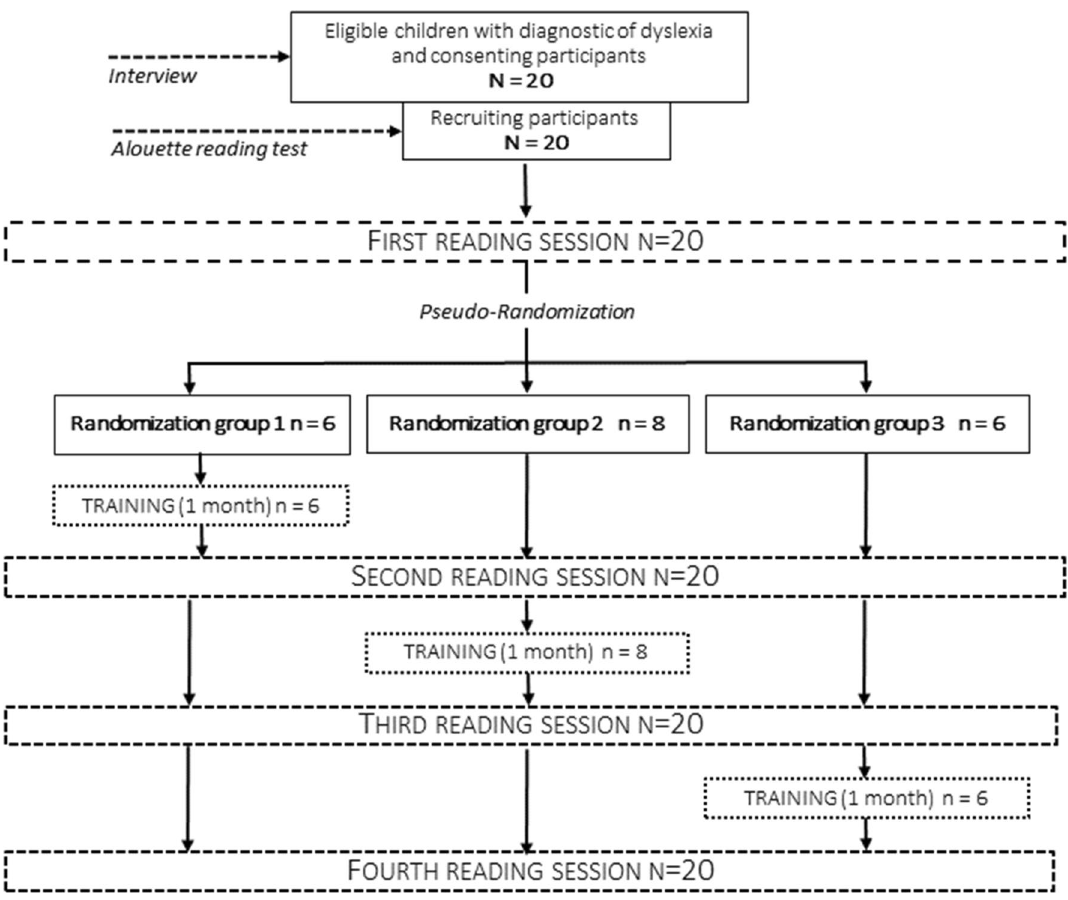
Figure 2. Flow chart illustrating participants’ recruitment and experimental